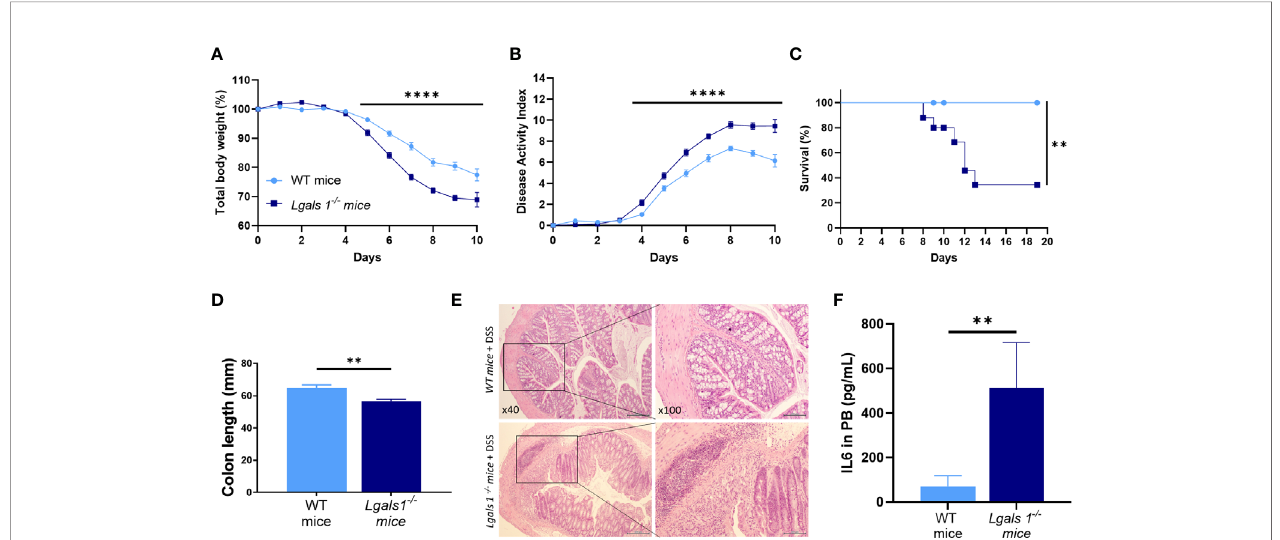
FIGURE 1 | Lgals1 − / − mice exhibited enhanced susceptibility to DSS-induced colitis. Colitis was induced with 1.25% DSS w/v in drinking water for 7 days ad libitum . Mice were monitored daily. (A) Total body weights with respect to the day 0 (%). (B) Disease activity index (DAI). (C) Survival of mice (n = 23 for WT and n = 25 for Lgals1 − / − mice per group) . (D) Colon lengths (n = 18 for WT and n = 17 for Lgals1 − / − mice per group). (E) Representative H&E colon tissue (×40 left, ×100 right magni fi cations, respectively). (F) IL-6 plasma concentration (pg/ml) (n = 8 for WT and n = 6 for Lgals1 − / − mice per group). Data are representative of three independent experiments. Statistical analysis was done using Mann – Whitney U test. Data are shown as mean ± SEM, **p < 0.01 and ****p < 0.0001